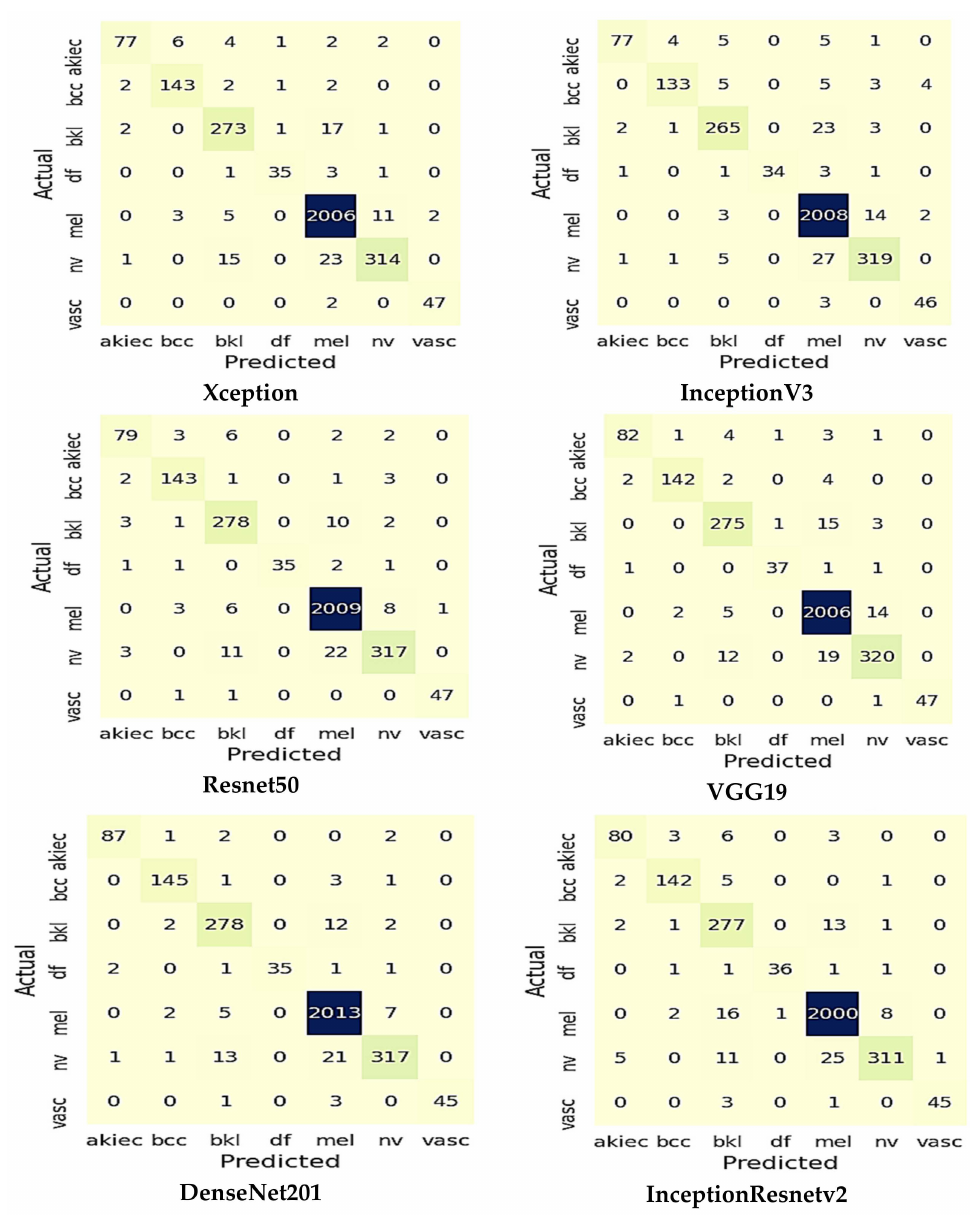
Figure 3. The confusion matrices for deep learning